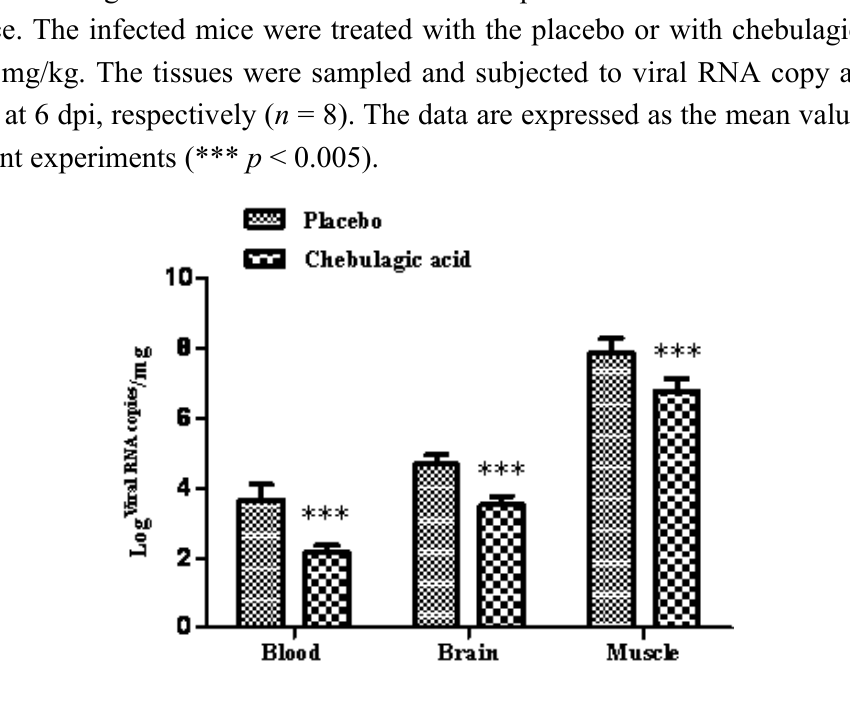
Figure 6. Chebulagic acid reduced pathological damage. The infected mice were treated with the placebo or chebulagic acid at a dose of 1 mg/kg. The pathological changes of muscle tissues at 9 dpi were observed after H & E staining. ( A ) The necrotising myositis was observed in the placebo-treated mice (the yellow arrow); ( B ) Moderate inflammation was observed in the muscle tissues of chebulagic acid-treated mice (the blue arrow). Magnification: